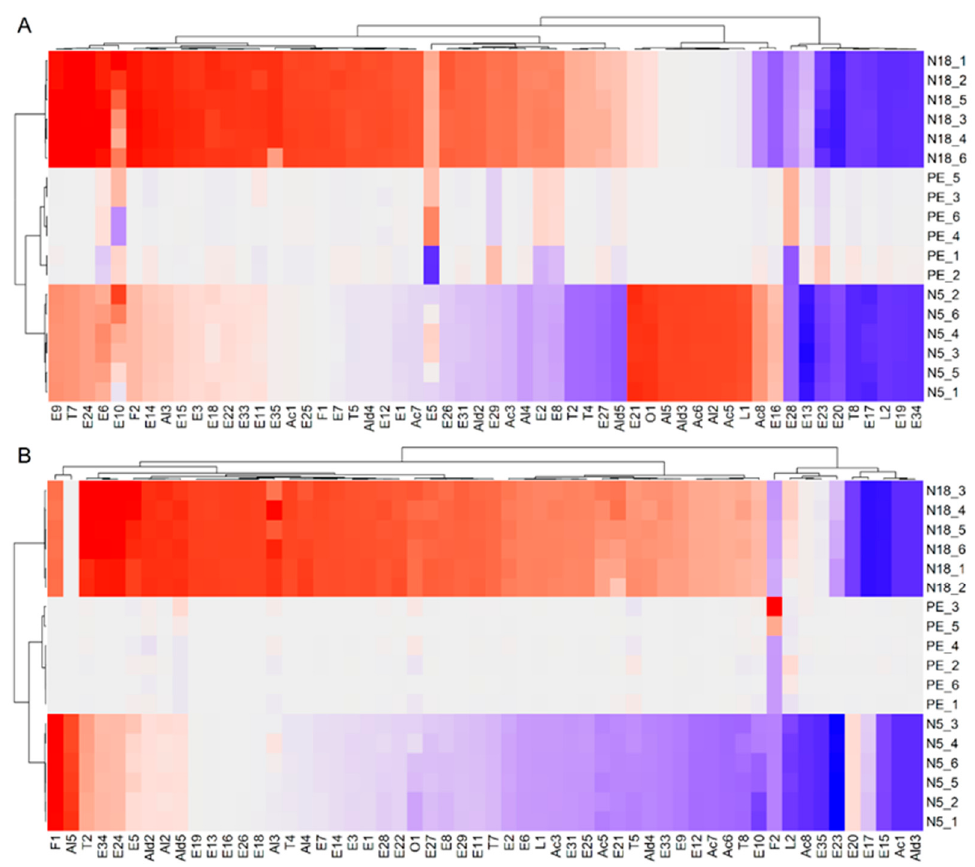
Figure 2. Heatmaps: Elide (panel ( A )) and Sabrina (panel ( B )). The colour scale ranges from blue, which indicates values lower than the median of the PE group, to red for values greater than the median of the PE group.